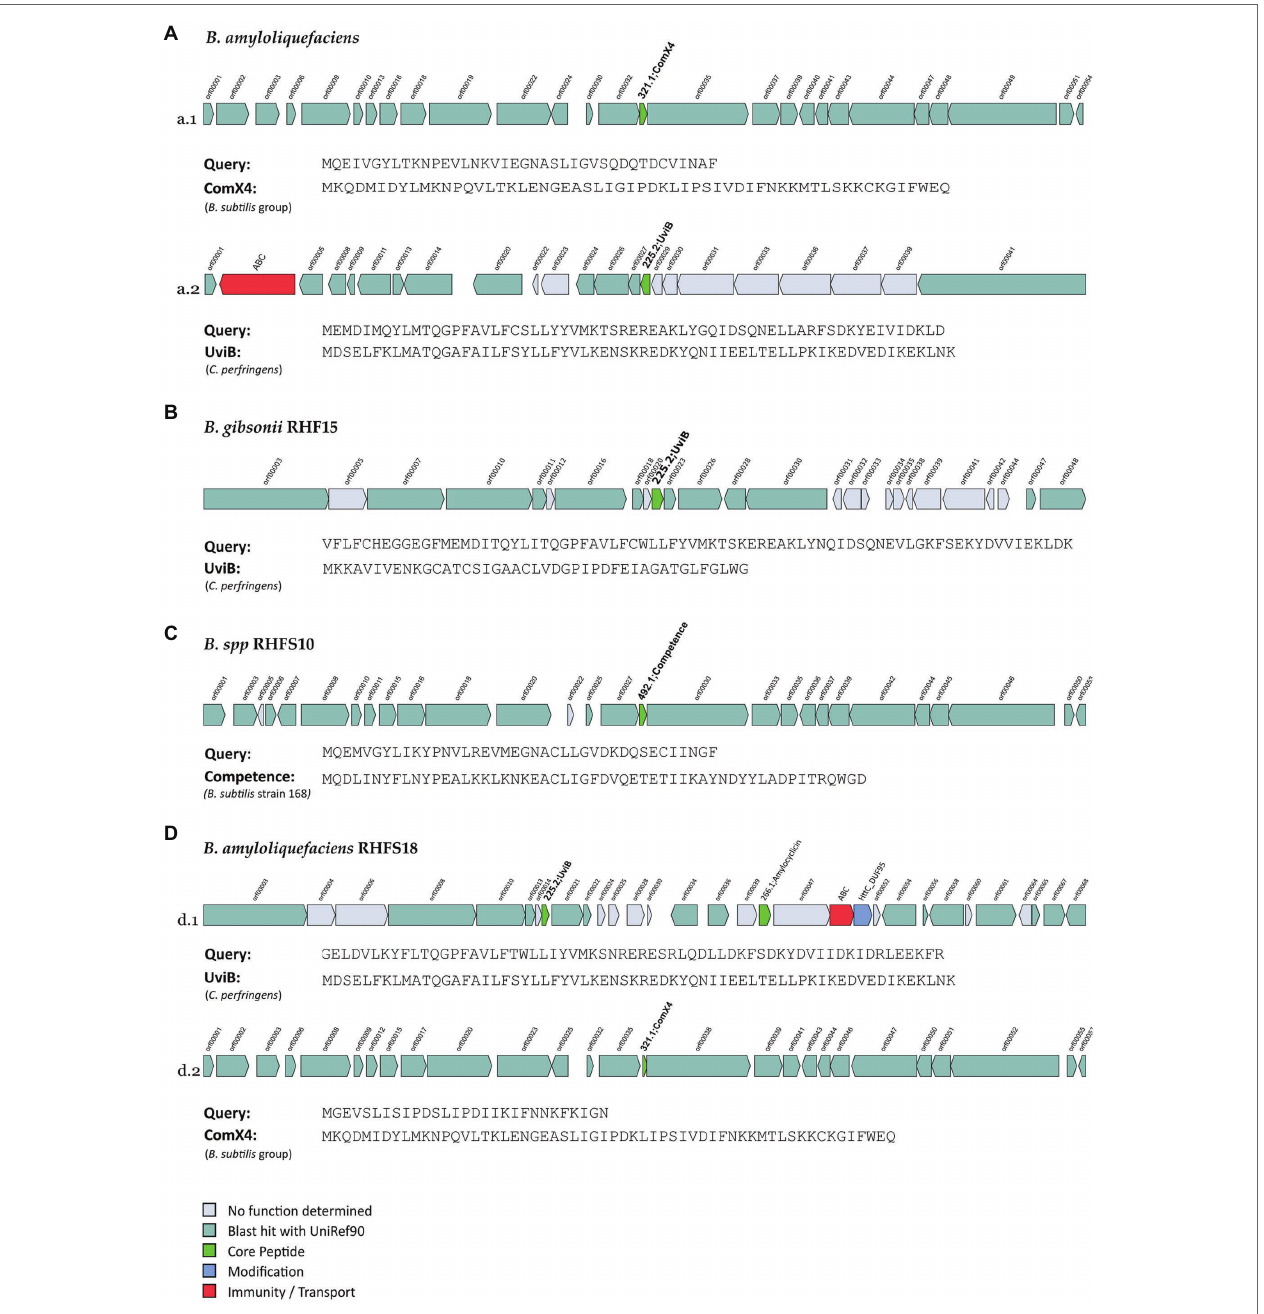
FIGURE 7 | Novel bacteriocins identified from the isolated Bacillus strains ( A: B. amyloliquefaciens, B: B. gibsonii RHF15, C: B. spp. RHFS10 and, D: B. amyloliquefaciens RHFS18). The BGCs identified from BAGEL4 analysis are shown and compared to the most similar available in BAGEL4 database.